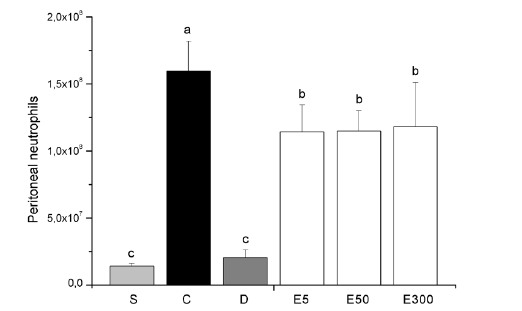
FIGURE 2 - Effect of the treatments on rats’ peritoneal neutrophils migration. Results are presented as means ± SD of seven animals per group. S = saline group; C = carrageenan group; D = dexamethasone group; E5, E50 and E300 = extracts groups. Different letters indicate statistical significance